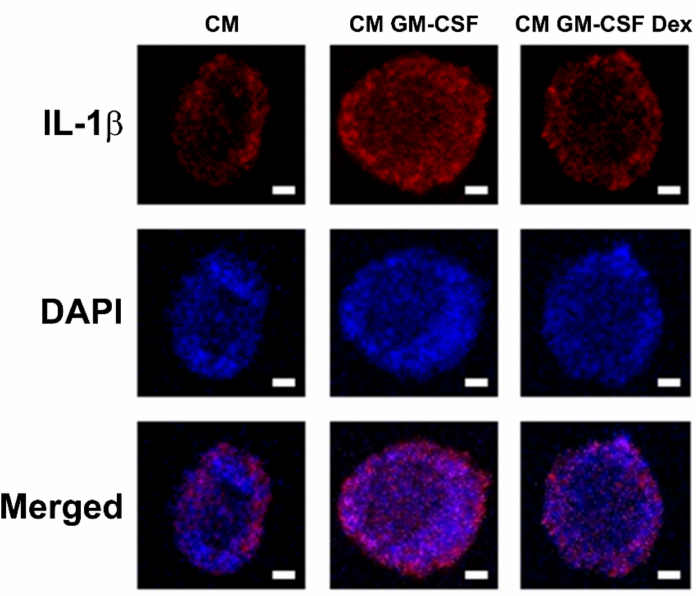
Figure 6. Effects of Dex on the expression of IL-1 β in CM-treated HaCaT cells. HaCaT cells were incubated with each medium (CM—CM from PBS-treated and unstimulated dHL-60 cells; CM GM- CSF—CM from PBS-treated and GM-CSF-stimulated dHL-60 cells; CM GM-CSF Dex—CM from Dex-treated and GM-CSF-stimulated dHL-60 cells) for 12 h. Fluorescence microscope images stained with an anti-IL-1 β antibody (scale bar = 2 µ m). Representative images were obtained from images performed in